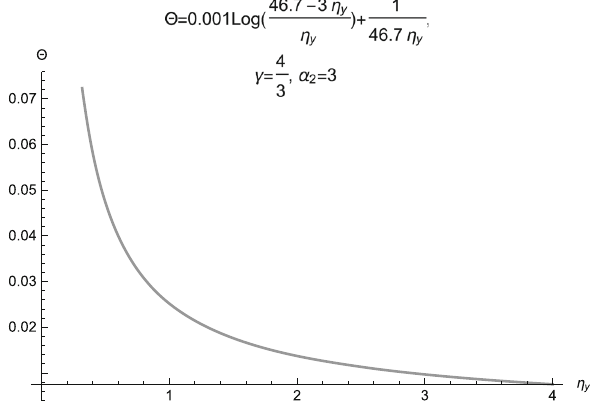
Fig. 24 The variation of (cid:16) with respect to η y for analysing stability at infinity for case III